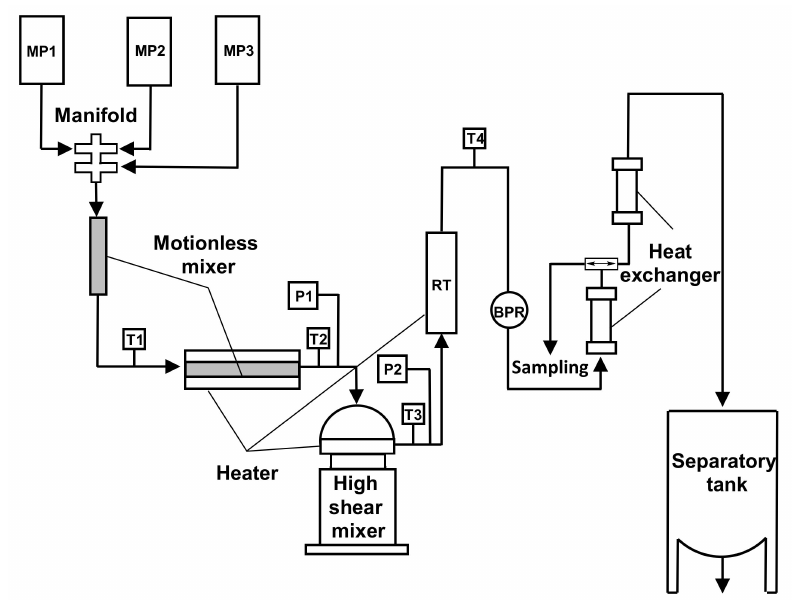
Figure 27. Flow diagram for the continuous transesterification process. Metering pumps (MP1. MP2, MP3); pressure transducers (P1, P2); back pressure regulator (BPR); thermocouples (T1, T2, T3, T4); residence tube